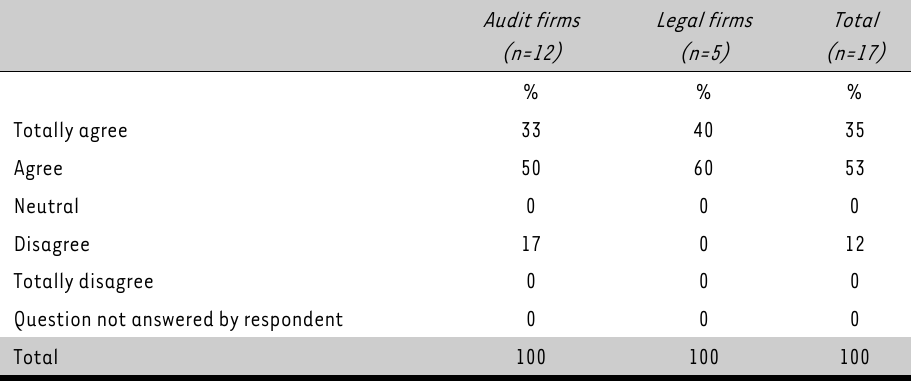
TABLE 3: Results of Question 4.4.1